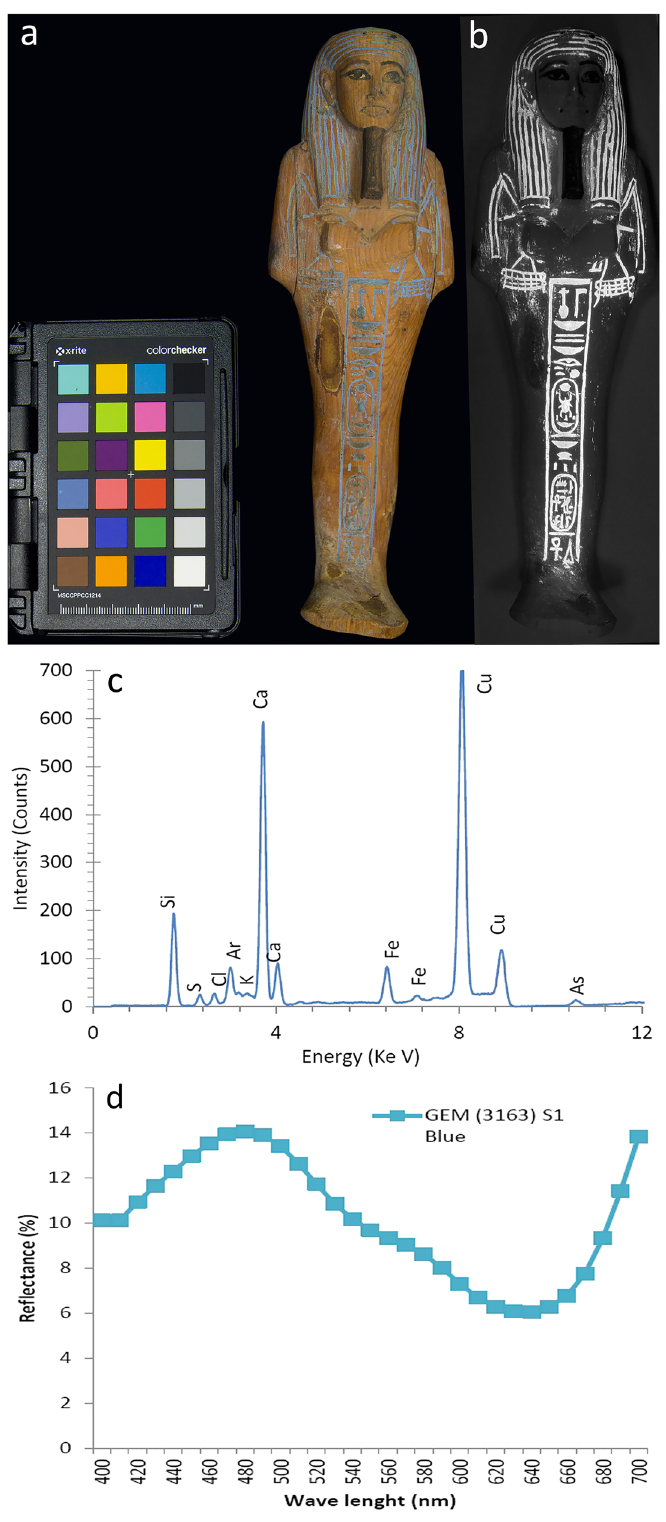
Figure 2: Characterization of the blue painted layer ( Object GEM 3163, Spot 1 ) : ( a ) visible image; ( b ) VIL image; ( c ) XRF spectrum; and ( d ) visible re fl ectance